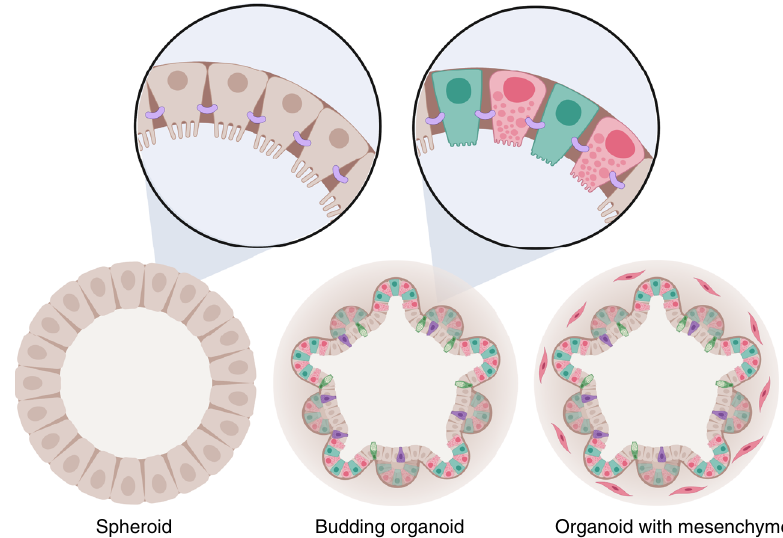
Fig. 2 Different types of organoids. Intestinal organoid architecture comes in different fl avours ranging from spherical structures to budding organoids (brown enterocytes, turquois intestinal stem cells, pink Paneth cells, purple enteroendocrine cells and green goblet cells) with distinct localisation of different cellular domains containing stem cells and differentiated cells, and organoids that include a supporting mesenchyme (illustrated with pink cells surrounding the organoid). The cells are arranged with the apical membrane inwards and with appropriate cellular junctions that normally support the formation of an intact barrier including tight junctions (purple). Created with